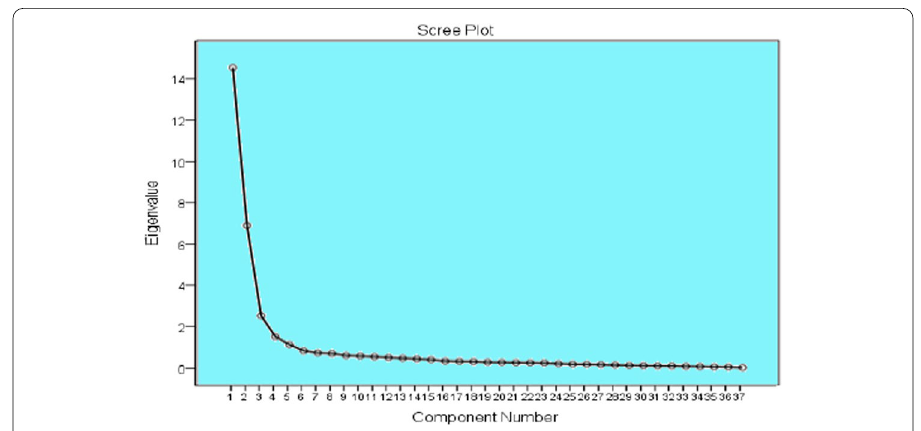
Fig. 1 Scree plot for APPRSQ in PCA